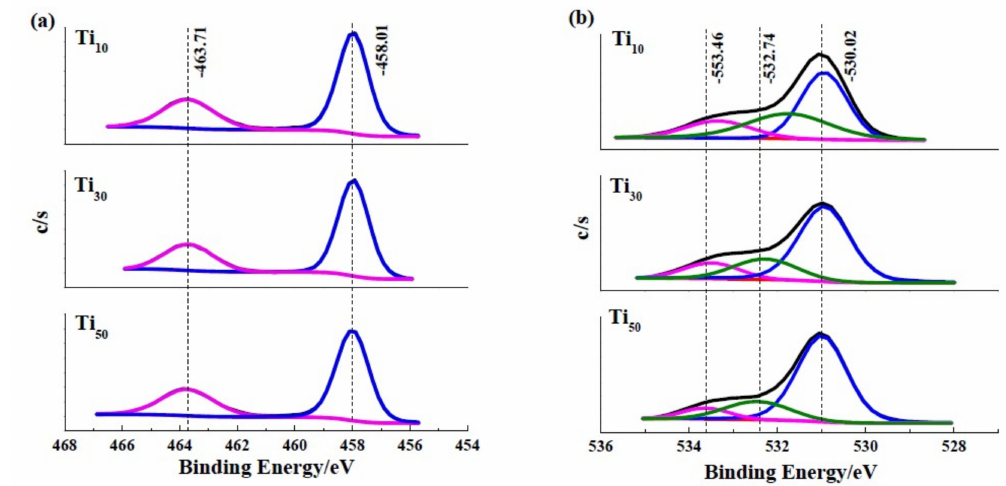
Figure 5. XPS analysis of the samples: ( a ) the narrow-scan spectrum of Ti 2p, ( b ) the narrow-scan spectrum of O 1s.